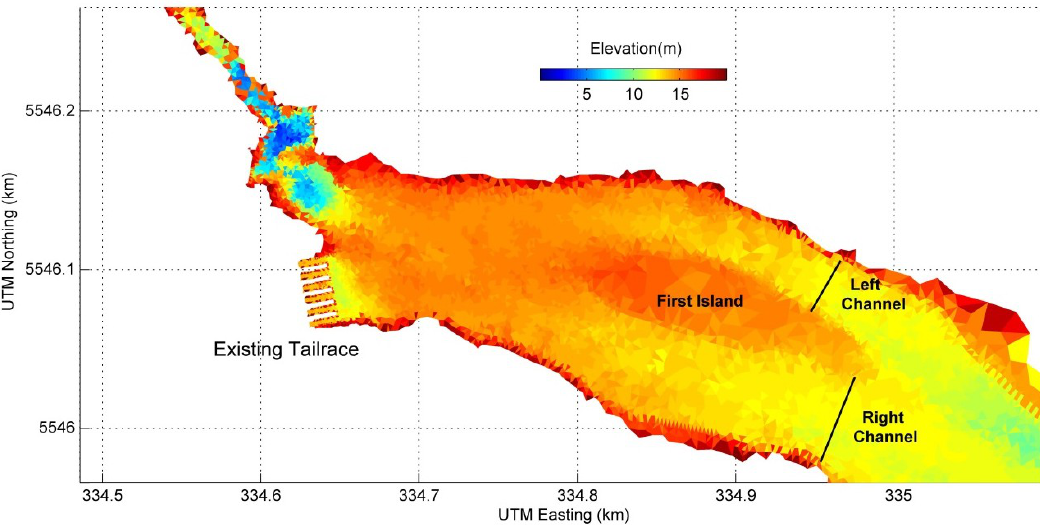
Figure 4. The existing tailrace and bathymetry features near the outlets and First Island. Solid black lines mark the sections used for ADCP and model flow split assessment.